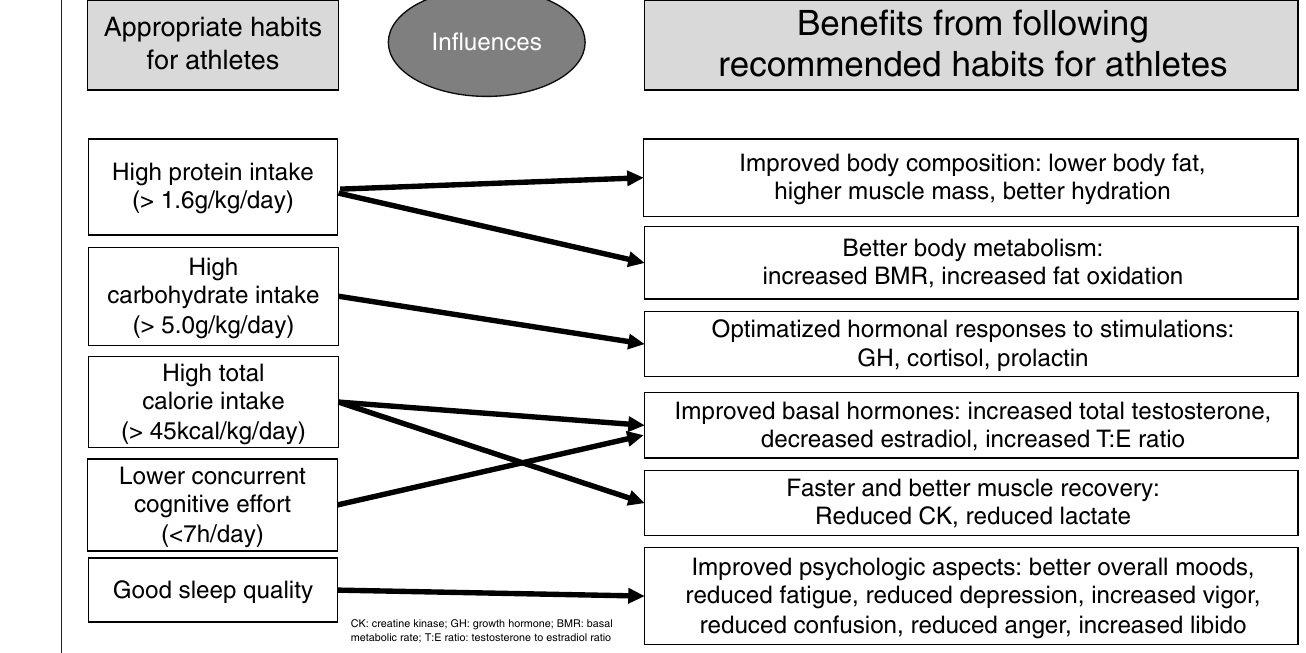
FIGURE 3 | Summary of the influences of modifiable patterns on clinical and biochemical